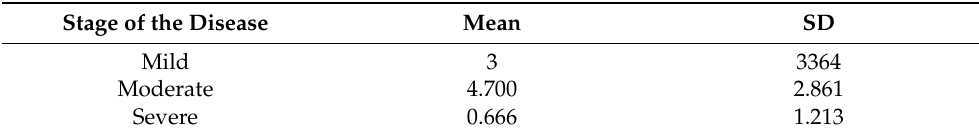
Table 11. Abuse in the different stage of the dementia.